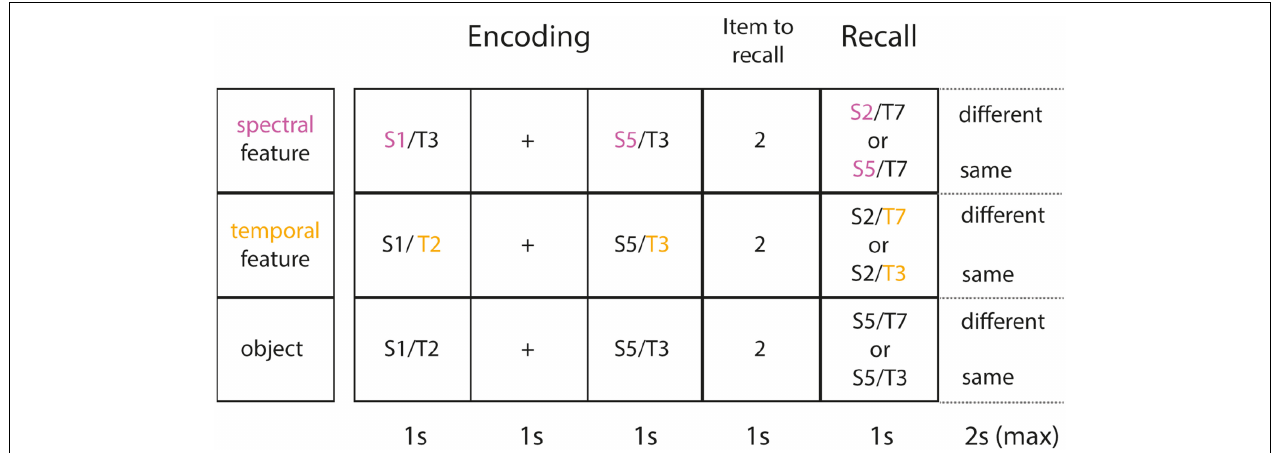
FIGURE 1 | Task and experimental conditions. Shown are sample trials for each experimental condition (each row illustrates one of 3 conditions). Note that the same material (2 auditory objects) is presented at encoding (identical across conditions). Each object is presented for 1s followed by an ISI of 1s. Next, a number appears onscreen for 1s, indicating which item in the sequence gets probed (here: 2 for 2nd item in the sequence). A final object is